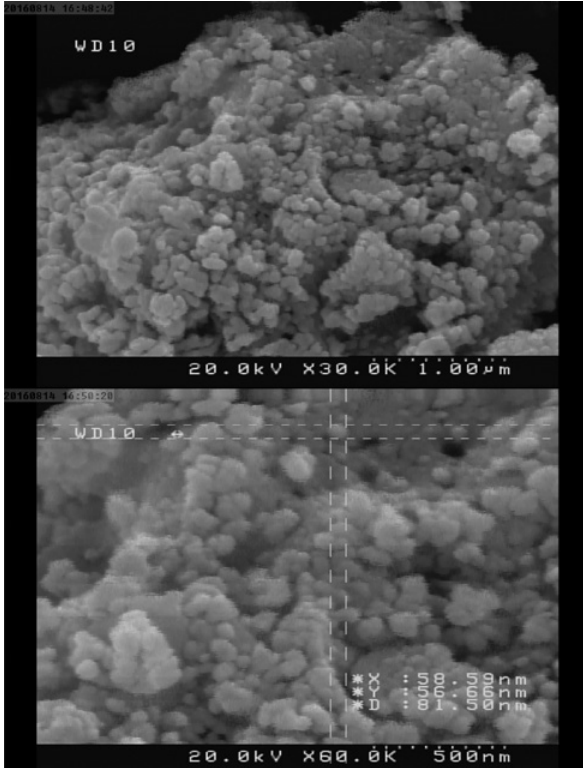
nanocomposite. 2